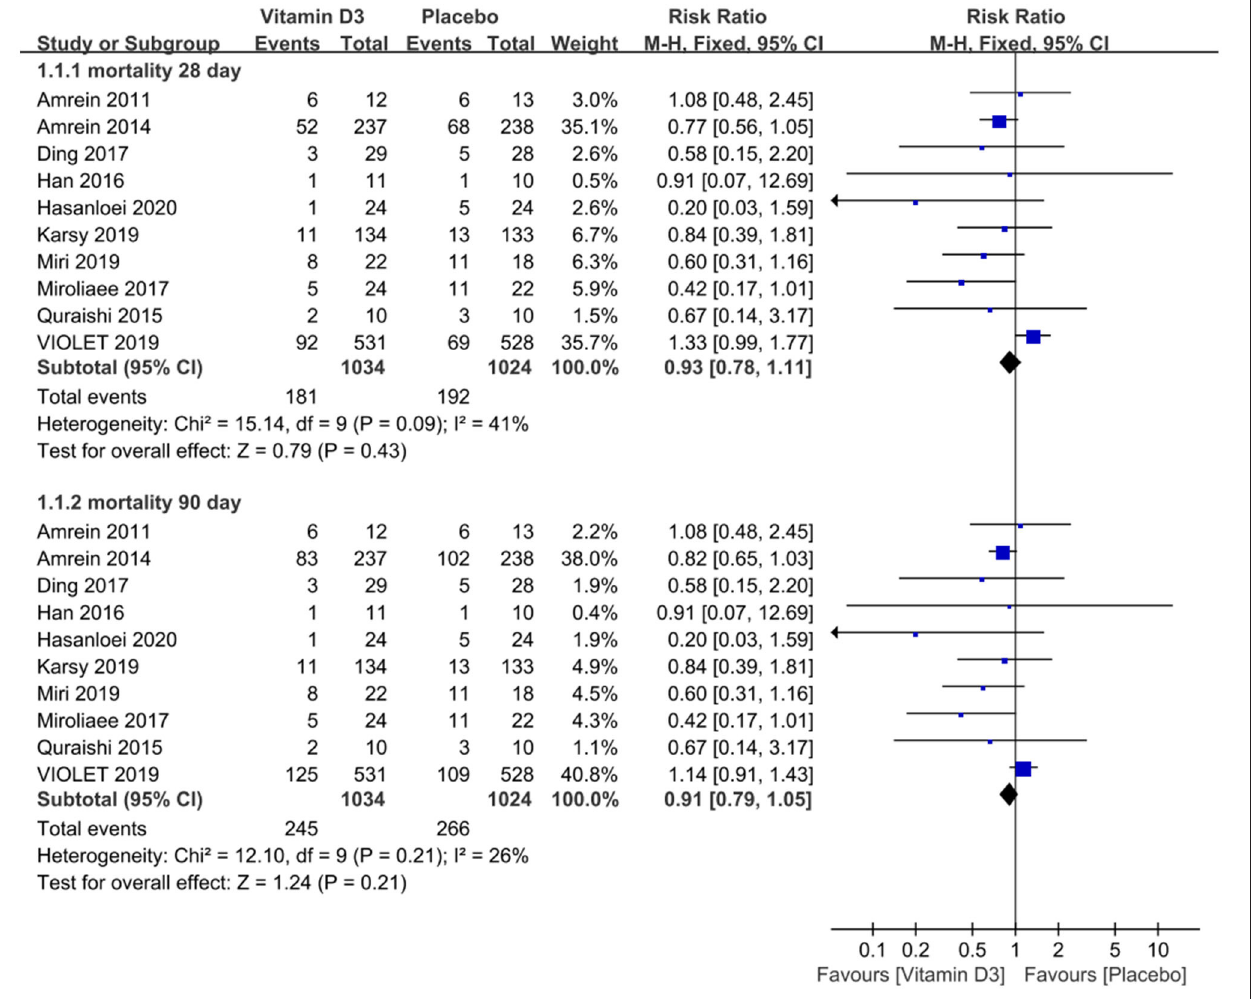
FIGURE 2 | The effect of vitamin D3 on mortality truncated to day 28 and day 90 in critically ill adult